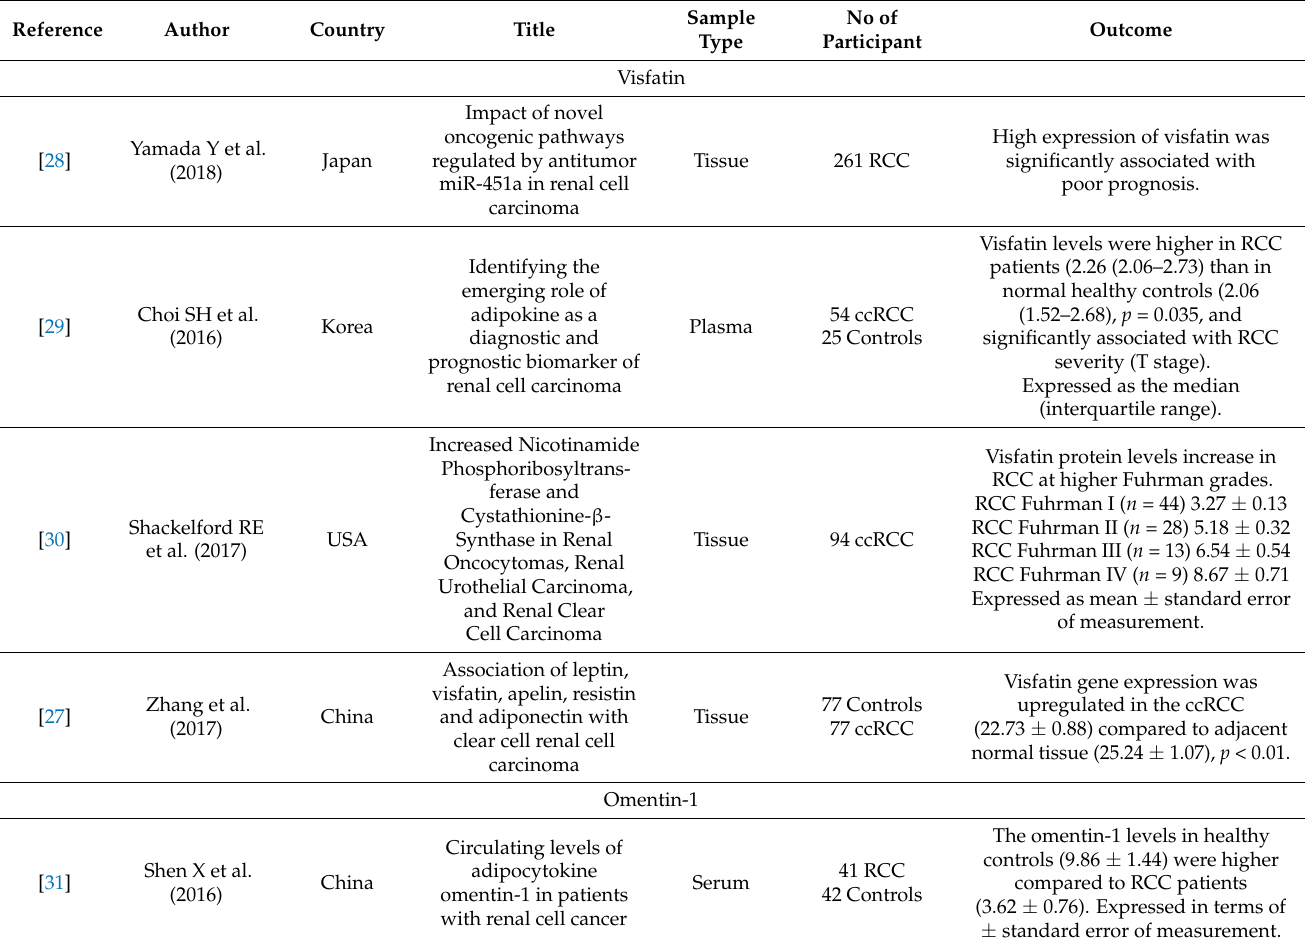
Table 2. Summary of visfatin and omentin-1